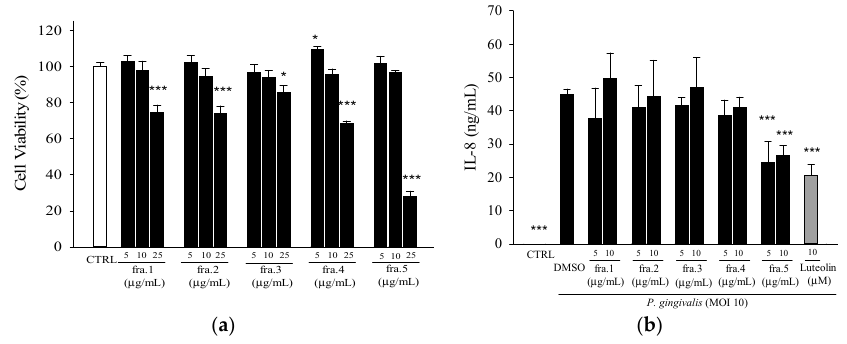
Figure 2. Effects of five sub-fractions from ethanol/ethyl acetate extract of WBM leaf on heat-killed P. gingivalis -induced IL-8 production. ( a ) Cell viability was determined by MTT assay. Cells incubated with 0.1% DMSO alone (CTRL), or the indicated concentrations of subfraction for 24 h. * p < 0.05 and *** p < 0.001 vs. CTRL; ( b ) IL-8 level was determined in cells co-incubated with P. gingivalis (M.O.I. = 10) and the indicated concentrations of samples for 24 h. Luteolin was a positive control. A control experiment (CTRL) without P. gingivalis treatment was conducted in parallel. Each column shows the mean ± SD of three independent experiments, each done in quadruplicate. *** p < 0.001 vs. DMSO vehicle ( P. gingivalis alone).